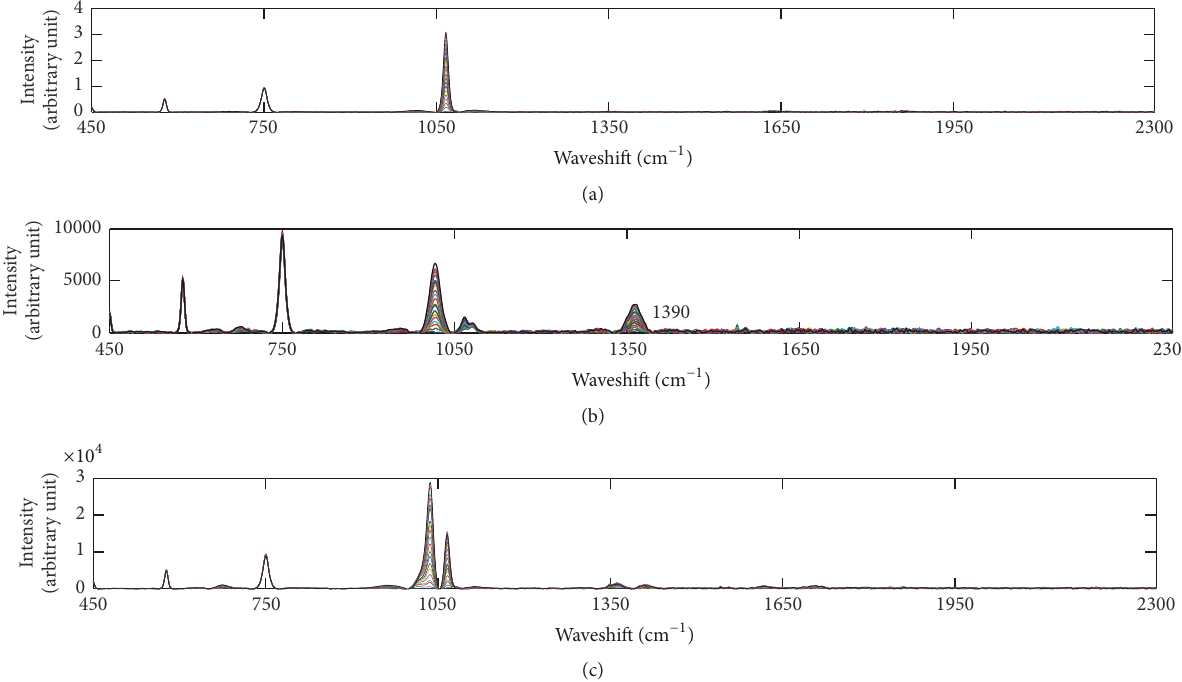
Figure 3: Raman spectra used in the PLS-R model calibration and validation. (a) Raman spectra of carbonate; (b) Raman spectra of bicarbonate; (c) Raman spectra of